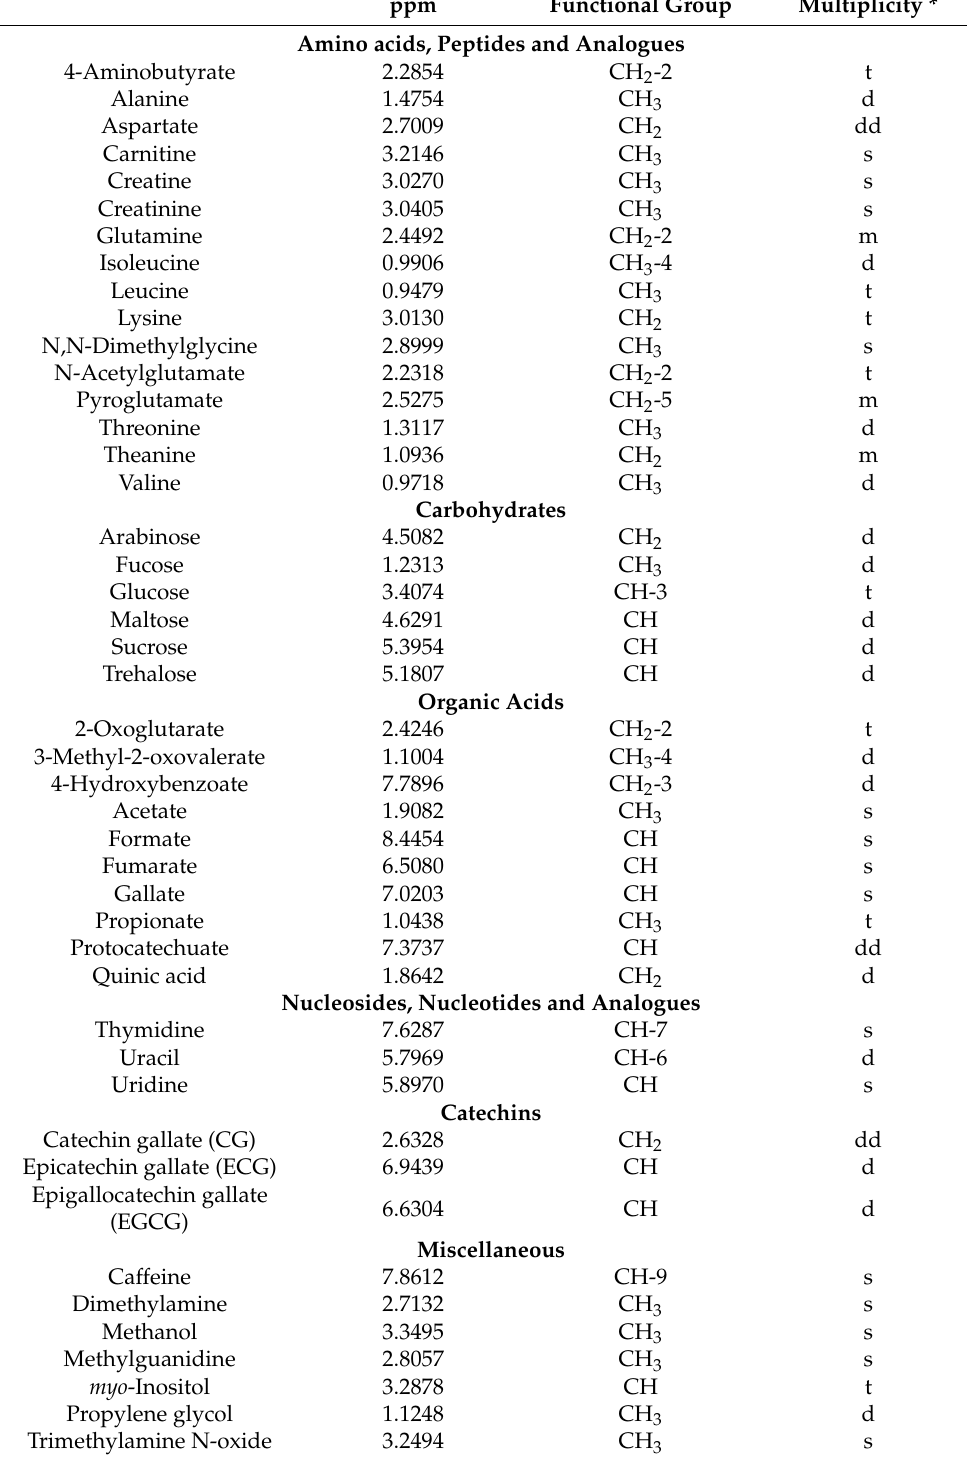
Table 1. Information for molecules identification by means of 1